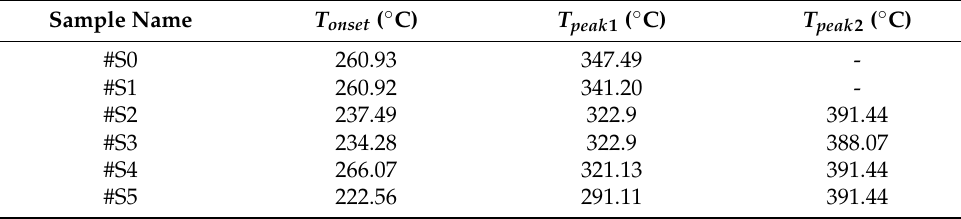
Figure 7. ( a ) Water stability and ( b ) porosity of the electrospun PLA and PLA/PEG-PPG-PEG nan- ofibers.